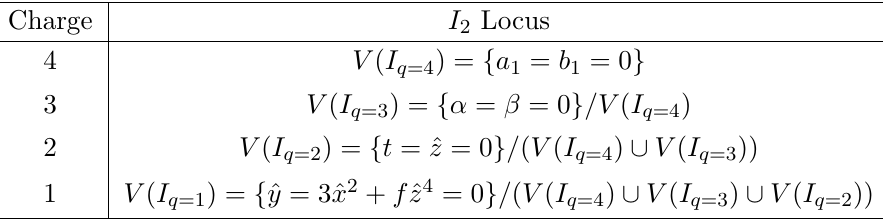
Table 6 . I 2 loci for the q = 4 construction along with the charges of the corresponding matter. Each locus is written as a variety V associated to an ideal I generated by two equations. (cid:11) and (cid:12) are de(cid:12)ned in (4.12), while t is given in (4.15).